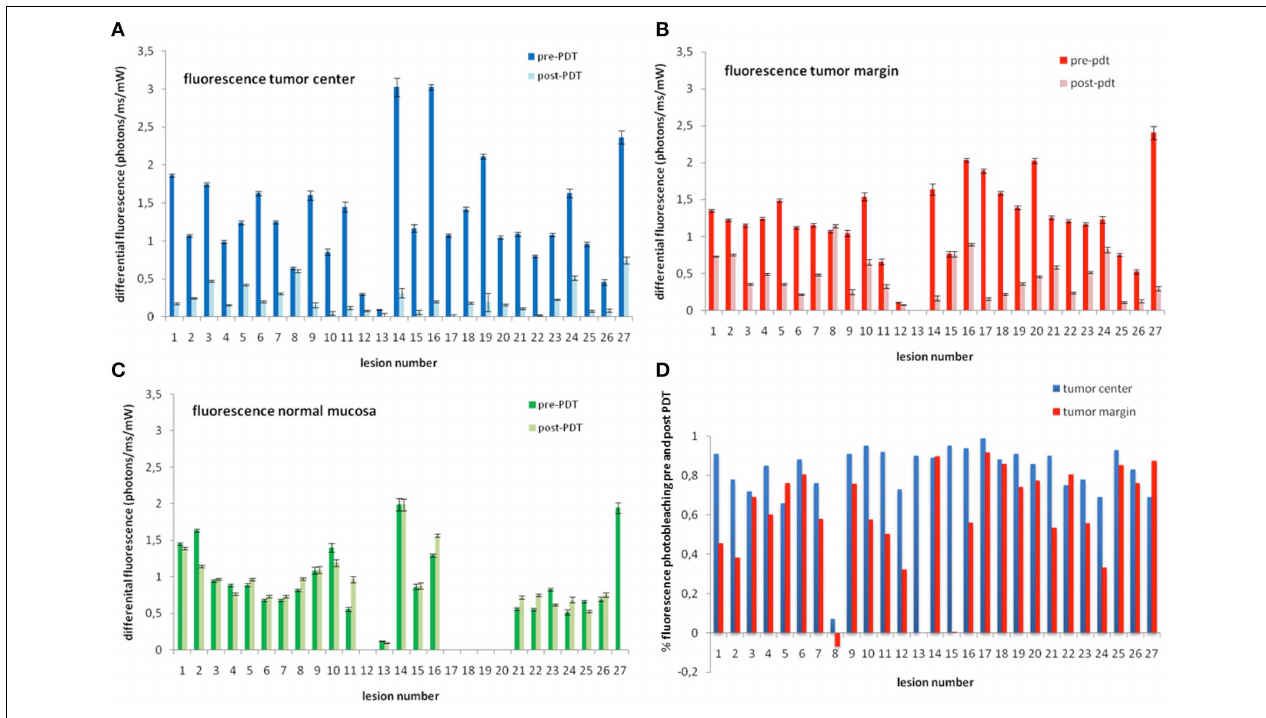
photobleaching (difference before and after PDT). Lesions 1, 2, 8, 15, and 24 show less than 50% photobleaching at tumor margins suggesting a geographic miss. There is no evident photobleaching in normal mucosa that did not receive PDT (panel C ). Missing or data that could not be evaluated are left blank. The numbers in all three graphs correspond to the same lesion/patient.